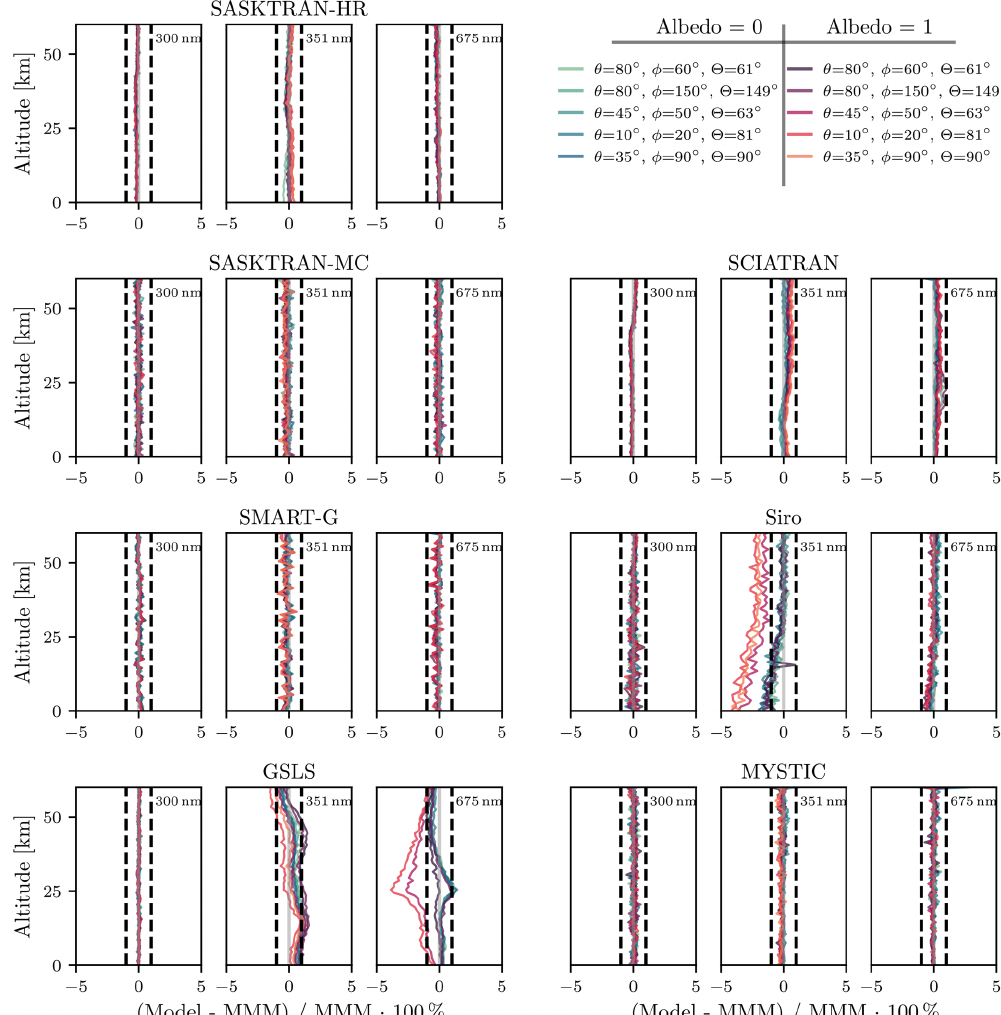
Figure 4. Percent differences in I , with multiple scattering enabled, relative to the MMM (MYSTIC, SASKTRAN-HR, SASKTRAN-MC, SCIATRAN, and SMART-G) for each RTM at a variety of wavelengths and solar conditions. The atmospheric optical properties include Rayleigh scattering, ozone absorption, and stratospheric aerosol Mie scattering. Refraction is disabled. Dashed vertical lines indicate ± 1%